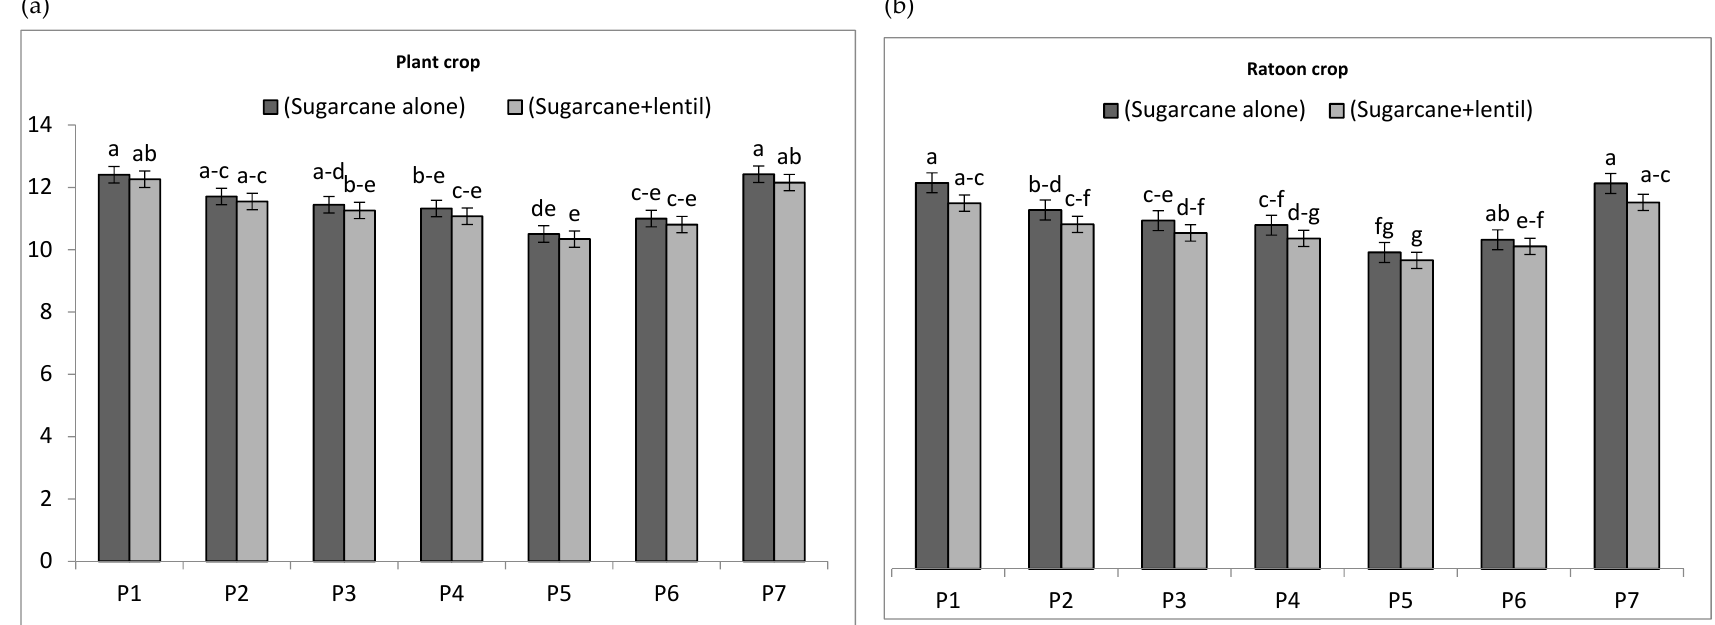
Figure 5. Crop growth rate (g m − 2 day − 1 ) of sugarcane as influenced by various planting patterns and lentil intercropping in (a) Plant crop and (b) ratoon crop. P 1 : 45 cm pits with 90 cm diameter, P 2 : 60 cm pits with 90 cm diameter, P 3 : 75 cm pits with 90 cm diameter, P 4 : 90 cm pits with 90 cm diameter, P 5 : 60 cm single rows planting, P 6 : 90 cm double rows planting, P 7 : Trench planting at 120 cm. Any two means not sharing a common letter(s) differ significantly at 5% probability.